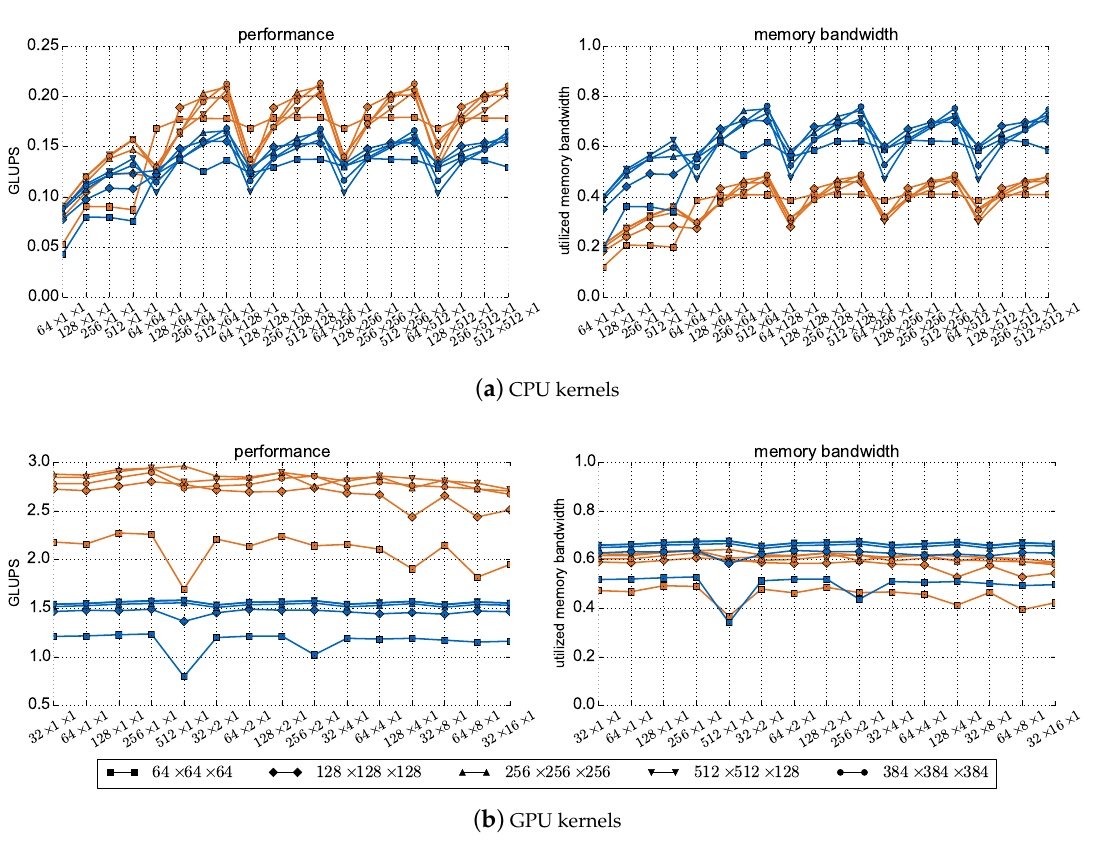
Figure 8. Performance in GLUPS (left) and share of utilized memory bandwidth in peak memory bandwidth (right). ( a ) Shows results for the CPU kernels, ( b ) for the GPU kernels. Values for the CPU depend on the block size used to increase cache efficiency and for the GPU on the parallel setup, each assigned to the abscissas. Different lines depict different problem sizes. Single precision ( float ) performance is colored in orange, double precision ( double ) performance in